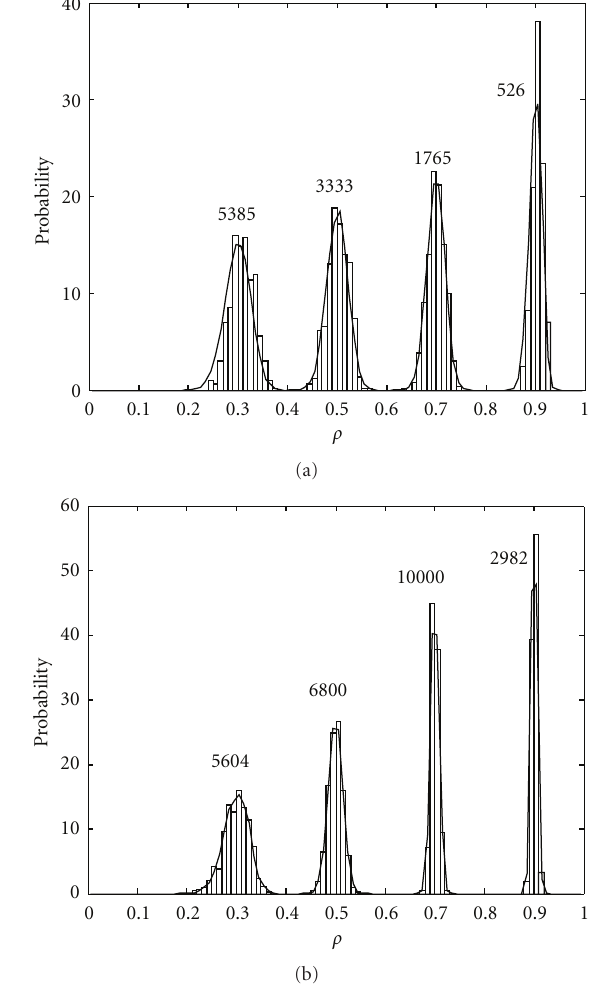
Figure 2: (a) PDF of the amplitudes on branch 1 of simulated sequence after sample selection, together with theoretical Rayleigh curve for s = 1. (b) PDF of the amplitudes on branch 2 of simulated sequence after sample selection, together with theoretical Rayleigh curve for s = 2.